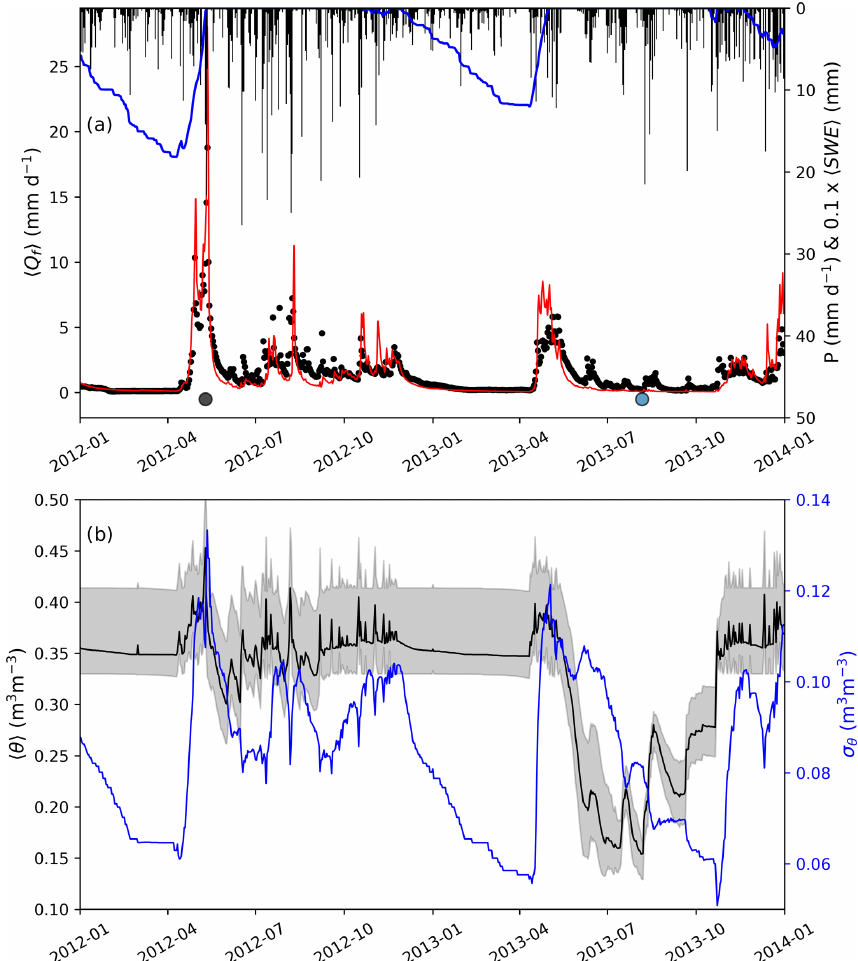
Figure 7. (a) Measured (black) and modeled (red) specific discharge Q f , daily precipitation P (black bars) and mean snow water equivalent SWE (blue); (b) mean volumetric soil moisture (cid:104) θ (cid:105) and its spatial standard deviation σ θ (blue) over two hydrologically contrasting years at C3 Porkkavaara, eastern Finland. In (b) the grey range shows the interquartile range. The points correspond to dates in Fig. 9. The Willmot’s index of agreement (Eq. 23) for specific discharge over 2012–2013 period is